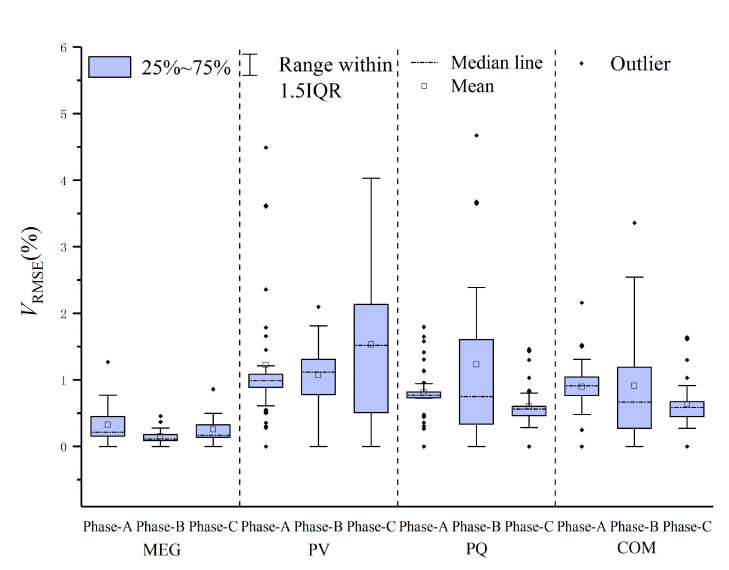
Figure 15. Mean square errors of four equivalent